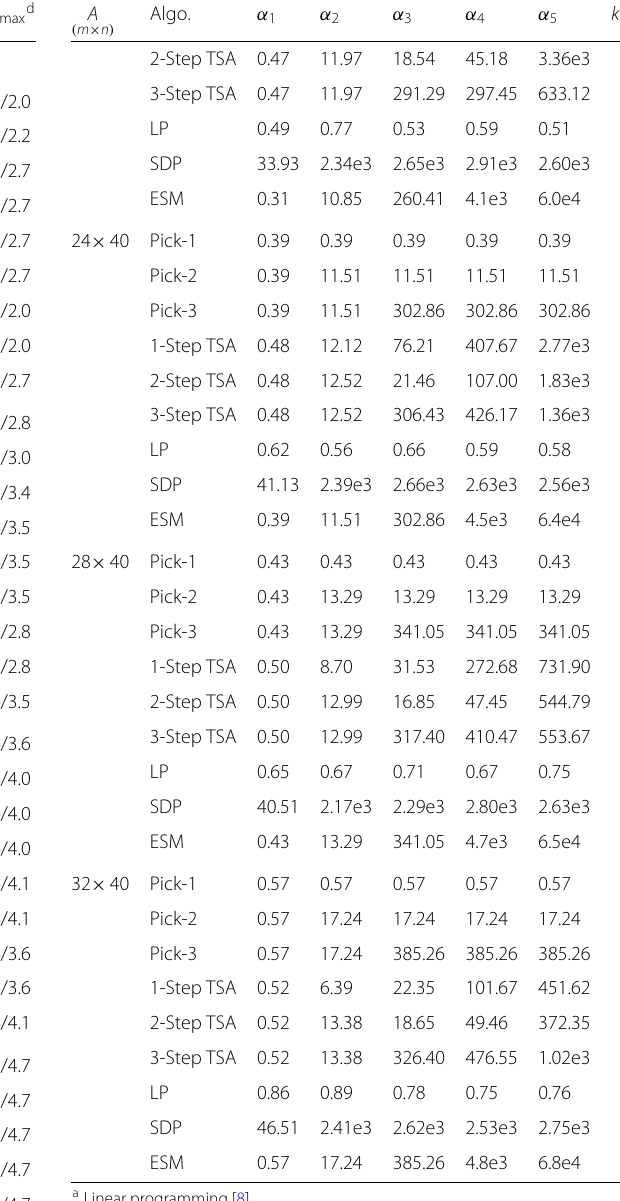
Table 8 α k comparison and execution time - Partial Fourier Matrix